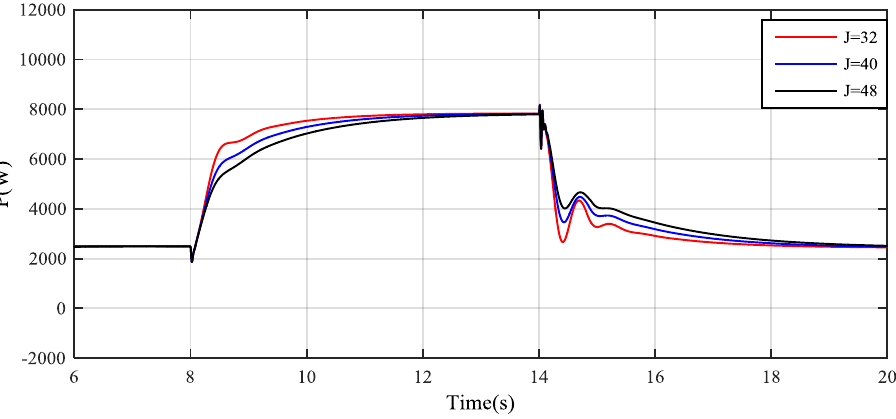
Figure 16. Active power of grid-feeding converter with different virtual inertia.